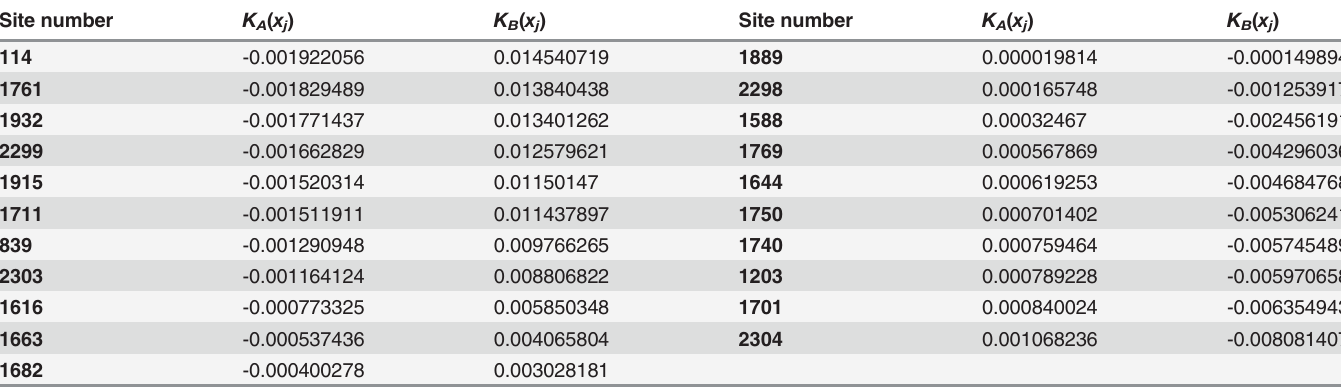
Table 2. Comprehensive correlation